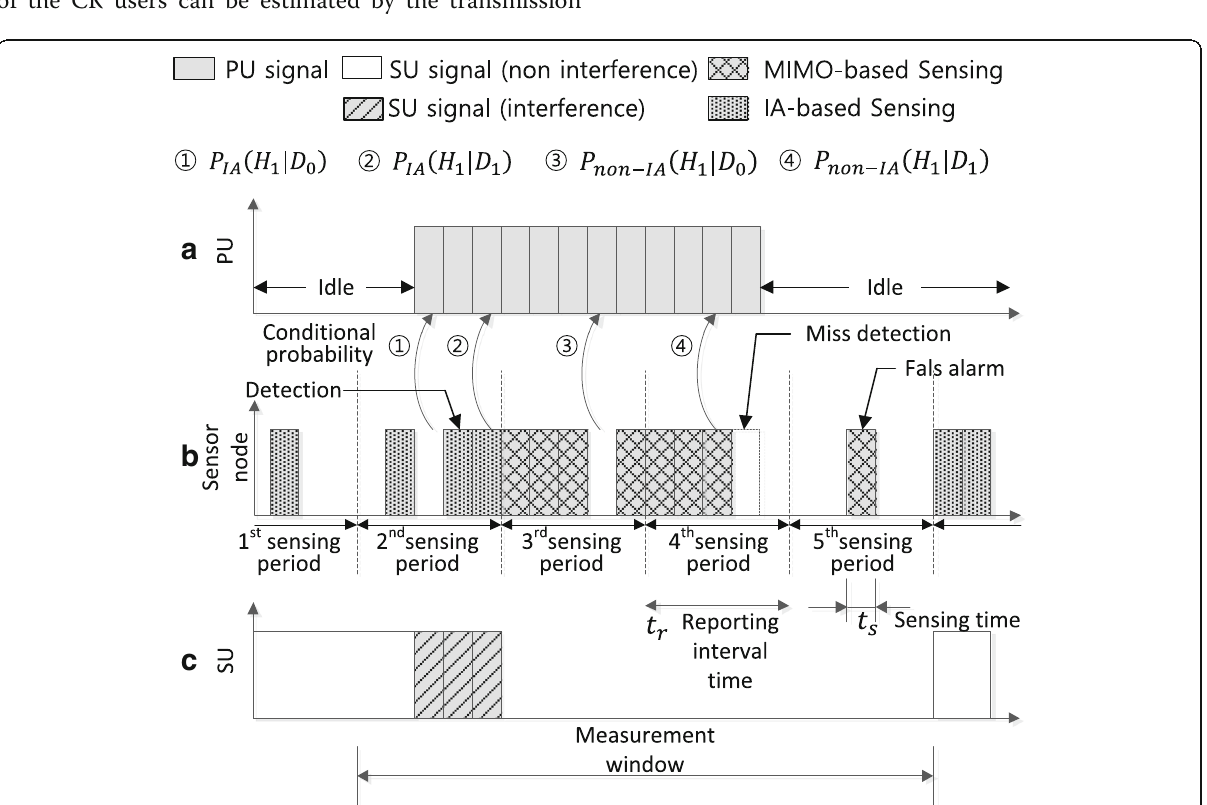
Fig. 5 Interference ratio. The interference ratio is the ratio between the conditional probability that the SU interferes with the PU and the PU exists within the measurement